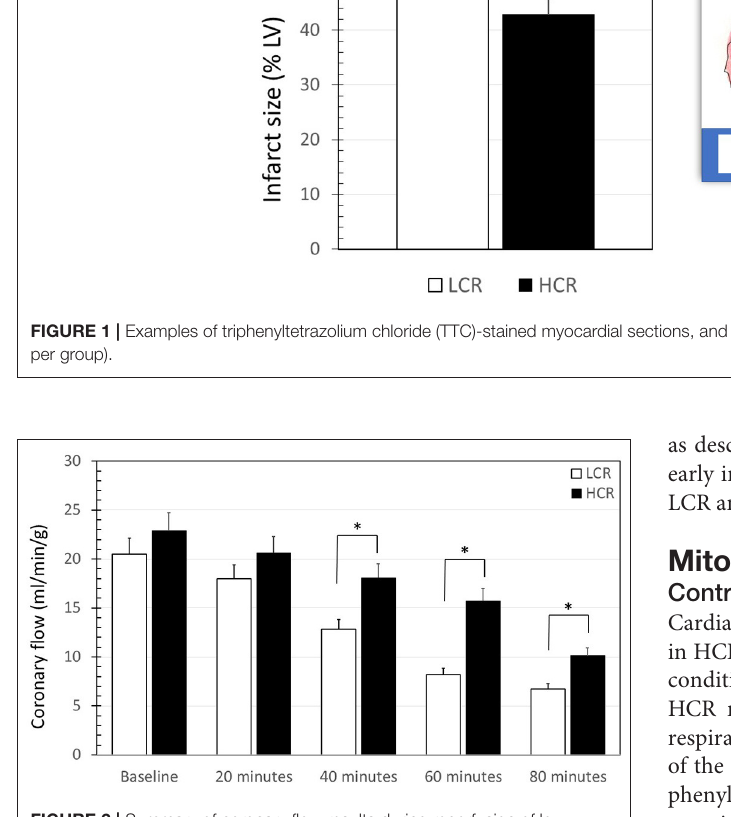
FIGURE 2 | Summary of coronary flow results during reperfusion of low capacity aerobic running (LCR) and high capacity aerobic running (HCR) hearts. Data are expressed as mean ± SD. n = 9 per group. * p < 0.05 in designated